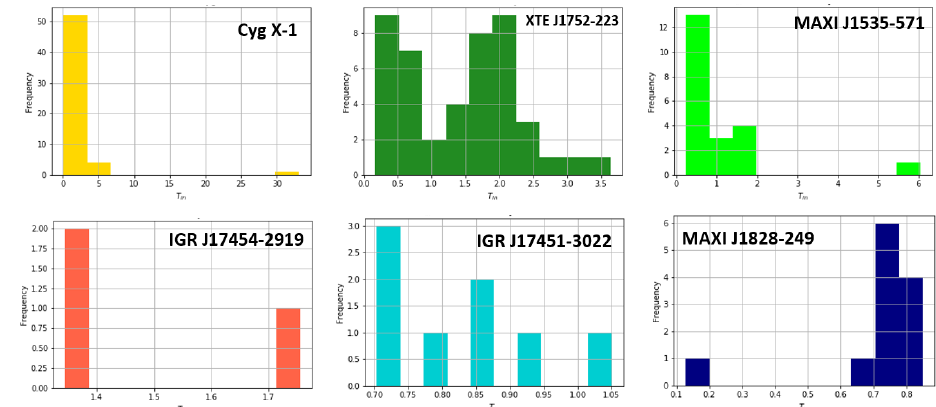
Fig. 2. Distribution of the disk innermost temperature for each candidate.